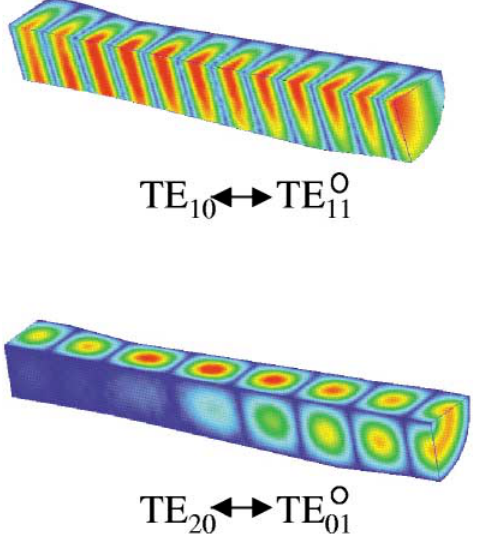
FIG. 3. (Color) Taper converter 1 (cid:1) 4 geometry, showing the tran- sition from the rectangular to the circular cross section, with field patterns illustrating conversion between TE 10 and TE ± 11 and be- tween TE 20 and TE ± 01 . FIG. 4. (Color) Profile of the diameter taper